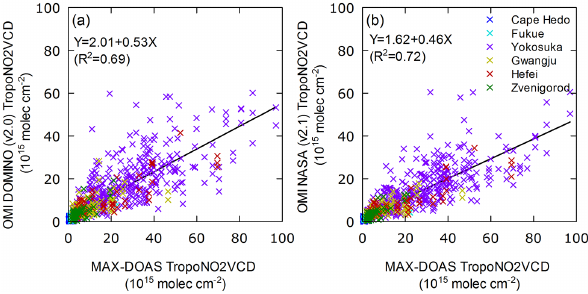
Figure 9. Similar to Fig. 8 but for pixel-based comparisons with strict coincidence criteria (horizontal displacement <0.15 ◦ , time difference <15min), and cloud screening (cloud fraction <10%); DOMINO (ver. 2.0) and NASA (ver. 2.1) were used for (a) and (b) ,